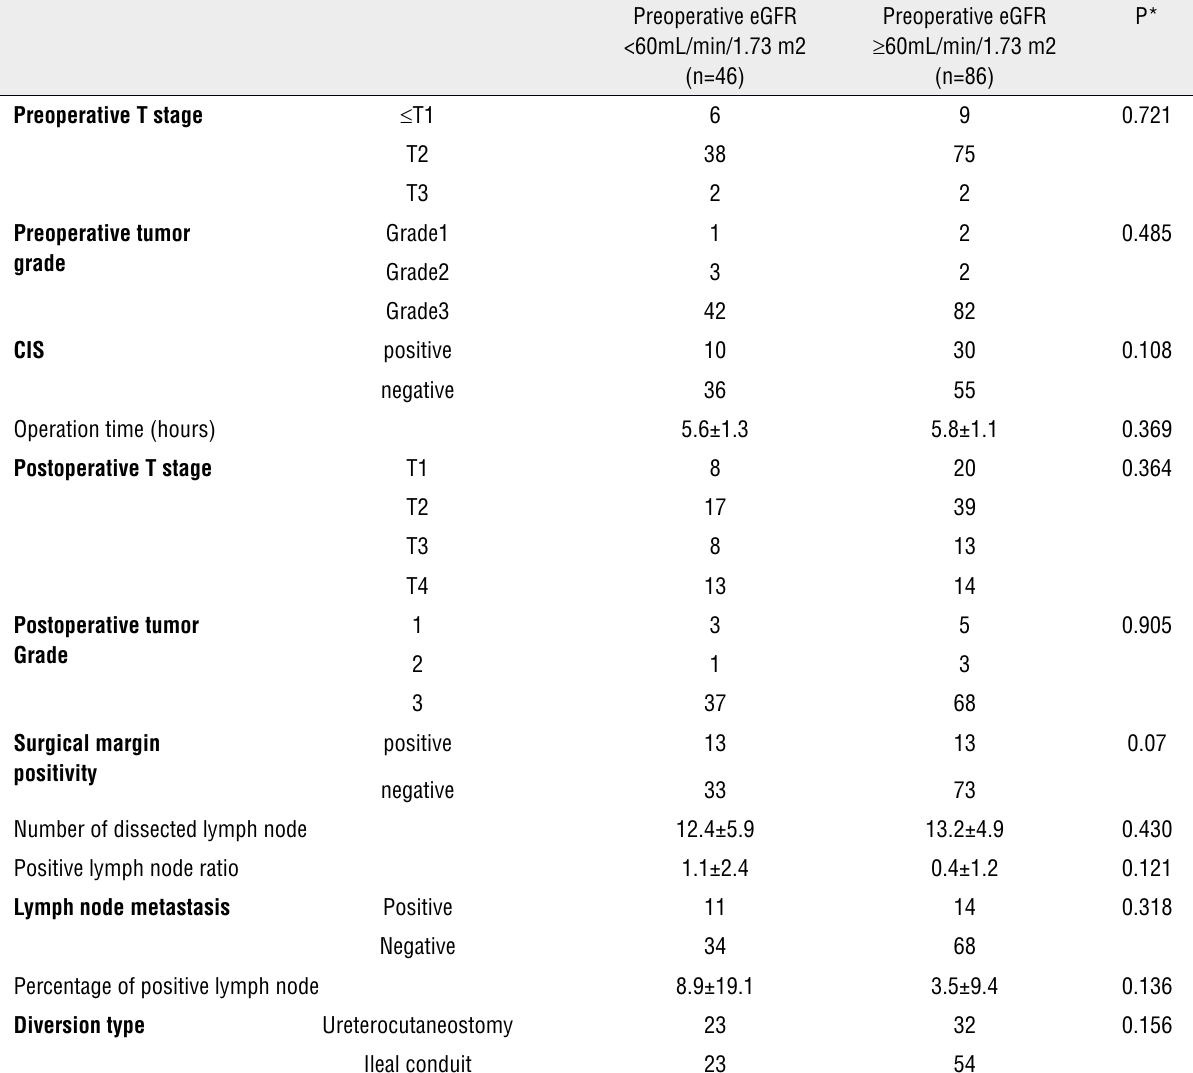
Table 2 - Comparison of operative and pathologic data between Group 1 and Group